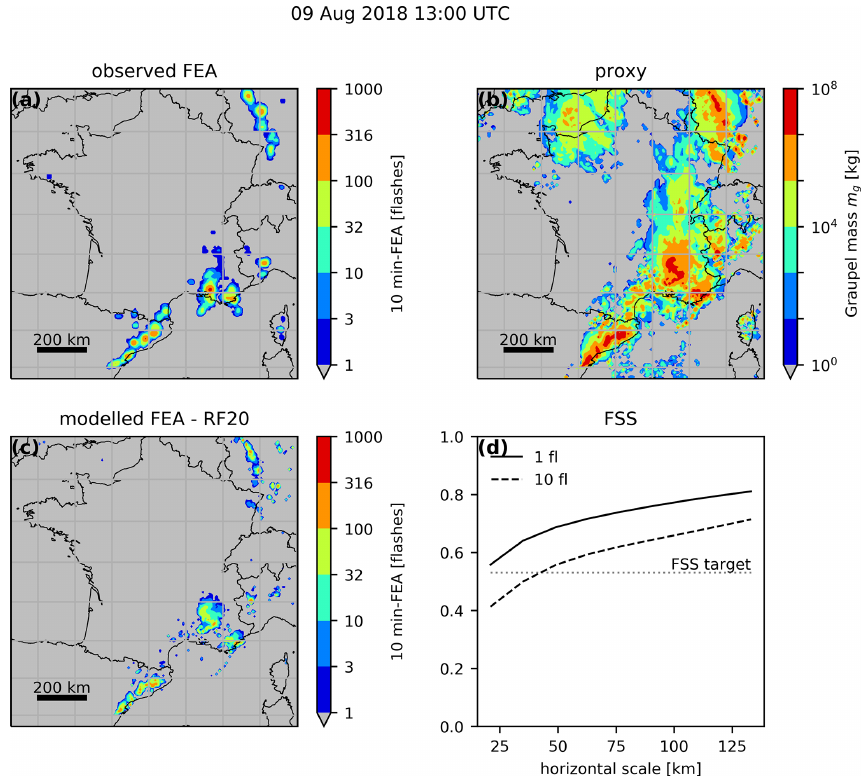
Figure 9. Spatial distribution over the studied domain for 9 August 2018 of (a) the observed FEA between 12:55 and 13:05UTC, (b) AROME-France simulated columnar graupel mass valid at 13:00UTC, and (c) RF20-based modelled FEA for 12:55 to 13:05UTC using the graupel mass. Panel (d) shows the FSS for the observed versus modelled FEA plotted as a function of the neighbourhood